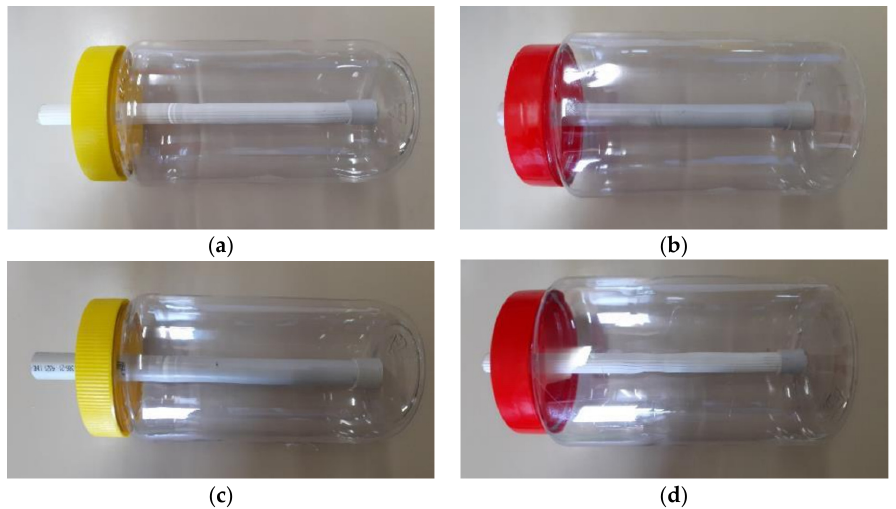
Figure 4. Four different types of bottle devices used in the experiments: ( a ) Ø 86 mm and PP inner tube; ( b ) Ø 105 mm and PVC inner tube; ( c ) Ø 86 mm and PVC inner tube; ( d ) Ø 105 mm and PP inner tube.